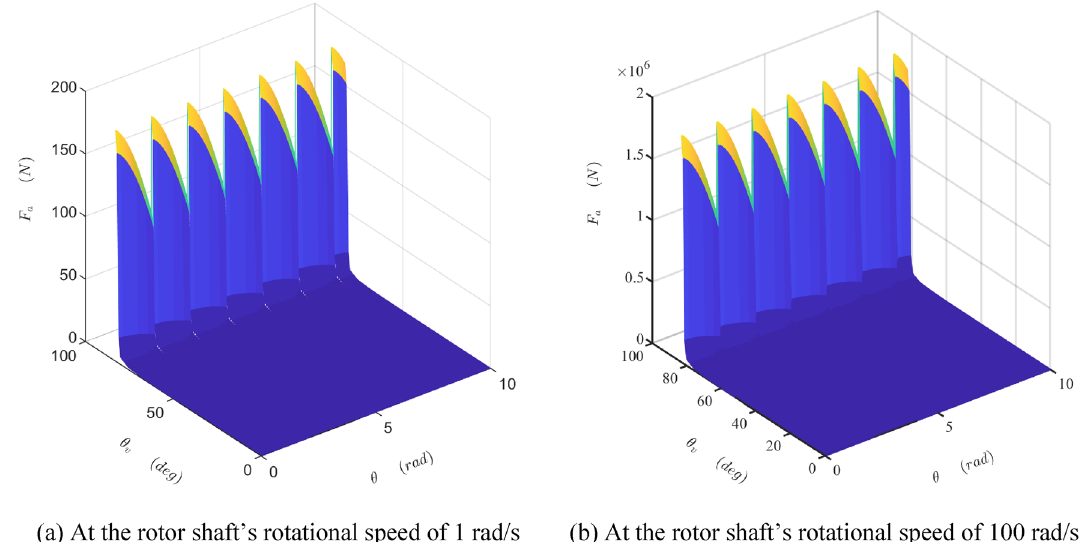
Figure 12. The map of the radial force produced by the fluid pressure acting on the cylinder surface of the rotor shaft at two different the rotor shaft’s rotational speed. (Matlab2019a. https:// ww2. mathw orks. cn/ produ cts/ get- matlab. html?s_ tid= gn_